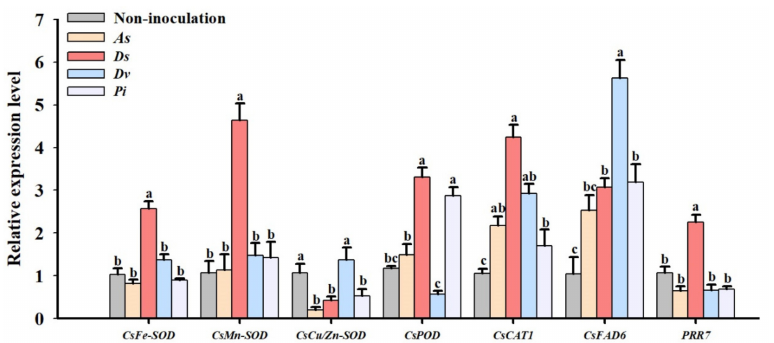
Figure 4. The effect of inoculation with Acaulospora scrobiculata (As), Diversispora spurca (Ds), D. versi- formis ( Dv ), and Piriformospora indica ( Pi ) on the relative expression level of leaf CsFe - SOD , CsMn - SOD , CsPOD , CsCAT1 , CsFAD6 , and CsPRR7 in lane late navel orange tree. Data (means ± SD, n = 3) are significantly different ( p < 0.05) if followed by different letters above the bars.